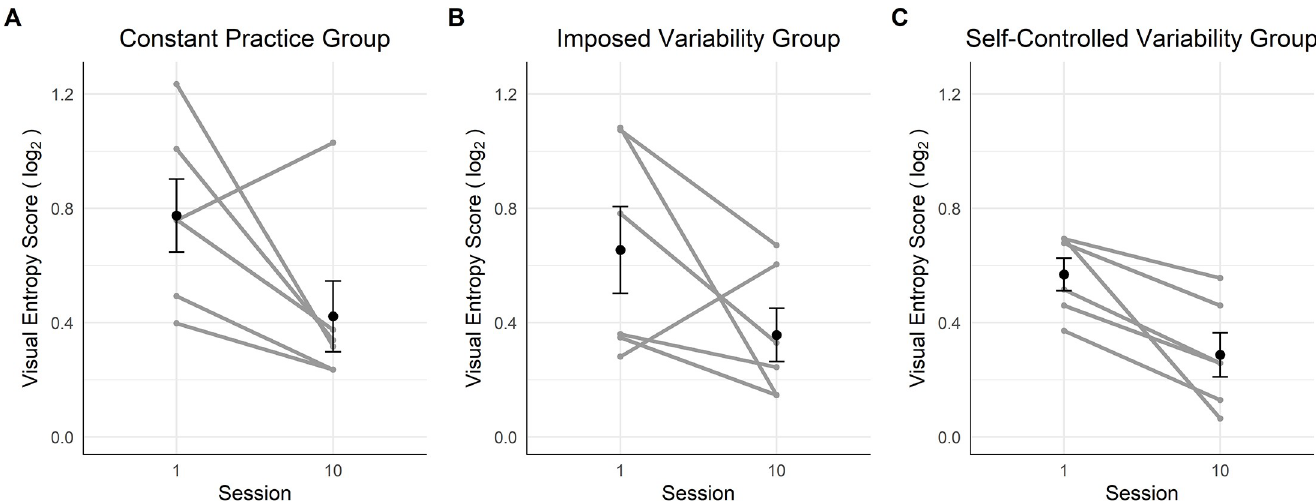
Fig 7. Changes in the complexity of the gaze path for the three groups on the transfer route. The black points represent the sessions mean and the error bars their standard error. The grey points and lines represent each participant’s dynamics.